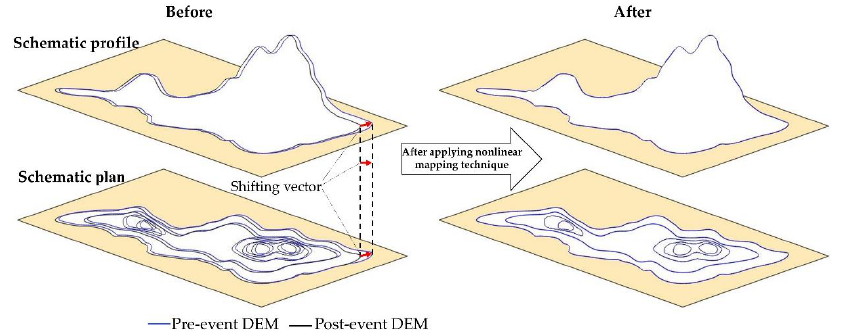
Figure 9. Schematic plan and profile denotes a comparison of DEMs before and after the nonlinear mapping-based geo- metric correction.